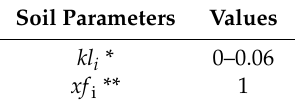
Table 6. APSIM root related soil input parameters used for scenario simulations. Soil Parameters